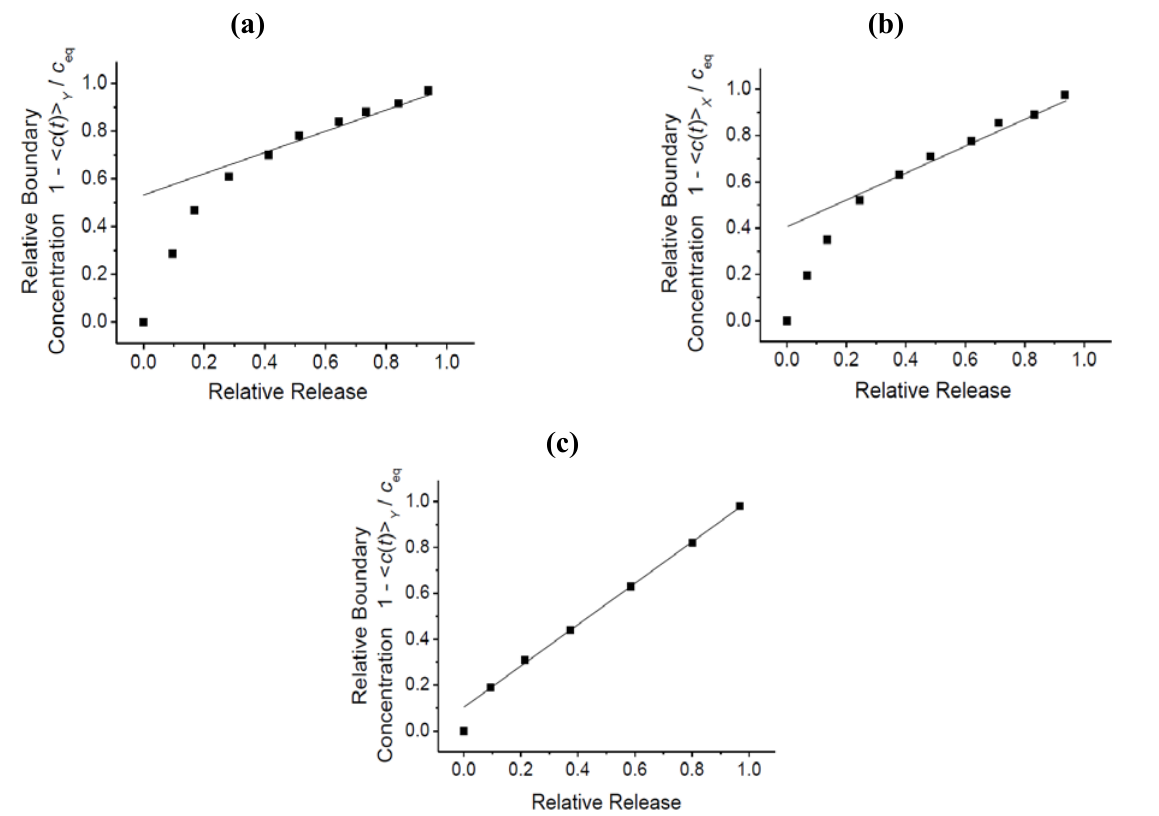
Figure 7. Relative boundary concentration as a function of relative release for benzene, calculated from the transient concentration profiles ( a ) in the X direction (shown in Figure 5c, area under the respective profiles; and ( b ) in the Y direction (shown in Figure 5d), and ( c ) for 4-methyl-2-pentyne (shown in Figure